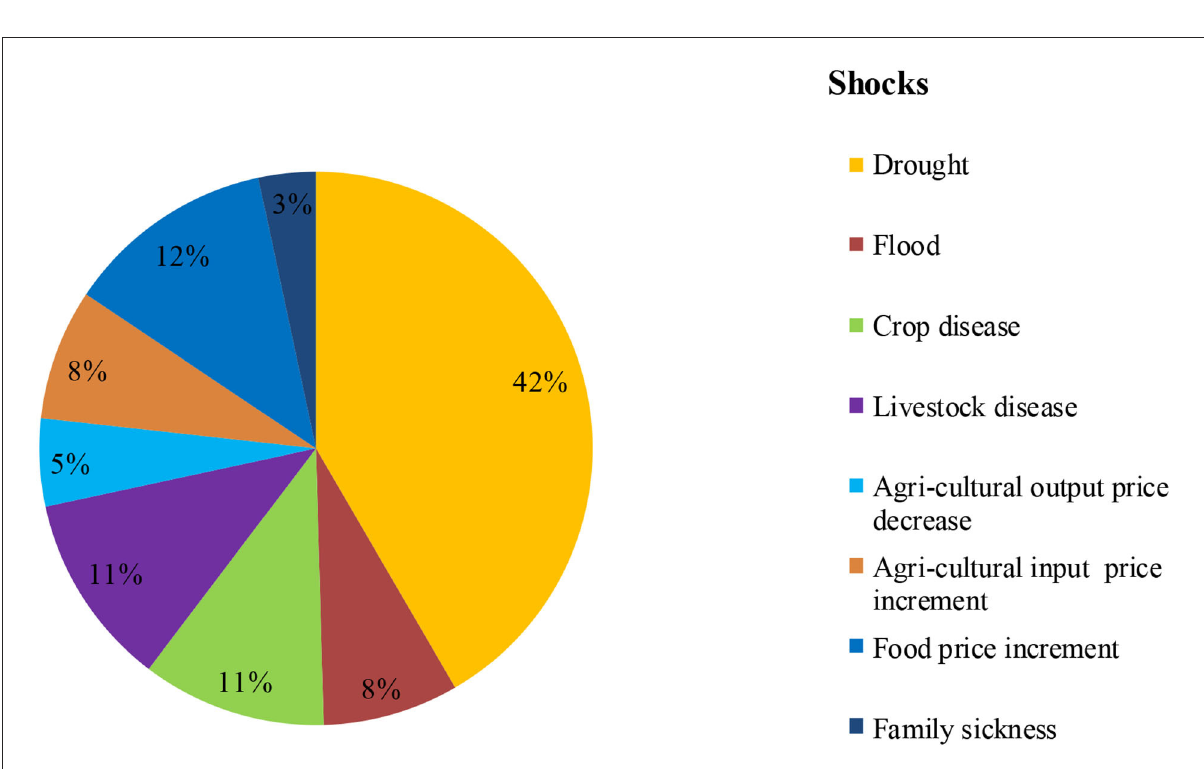
FIGURE4 Severity of different livelihood